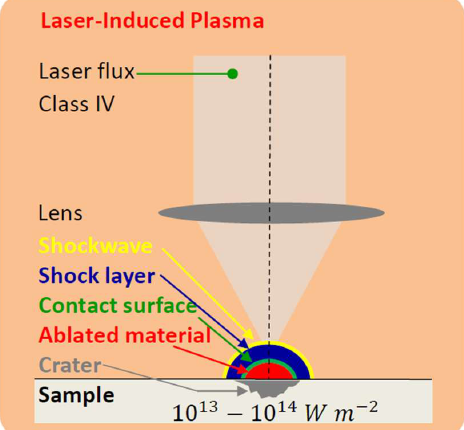
Figure 6. Laser-induced plasma situation. The laser pulse is focused on the sample using a converging lens at an irradiance higher than the breakdown threshold. The ablated material expands according to a hypersonic regime and produces a shock wave propagating in the background gas. As a result, two layers are formed. The first one corresponds to the ablated material and the second one corresponds to the shock layer. These two layers are separated by a contact surface across which the diffusion phenomena can be considered as negligible in a first approximation.